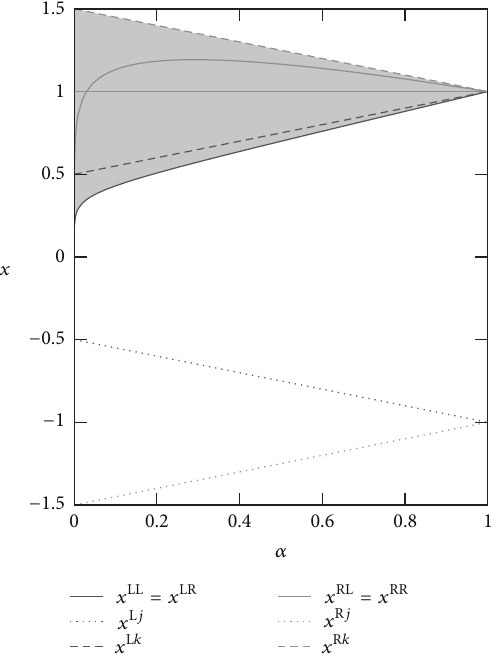
Figure 4: Solution candidates for 𝑥(𝛼) .